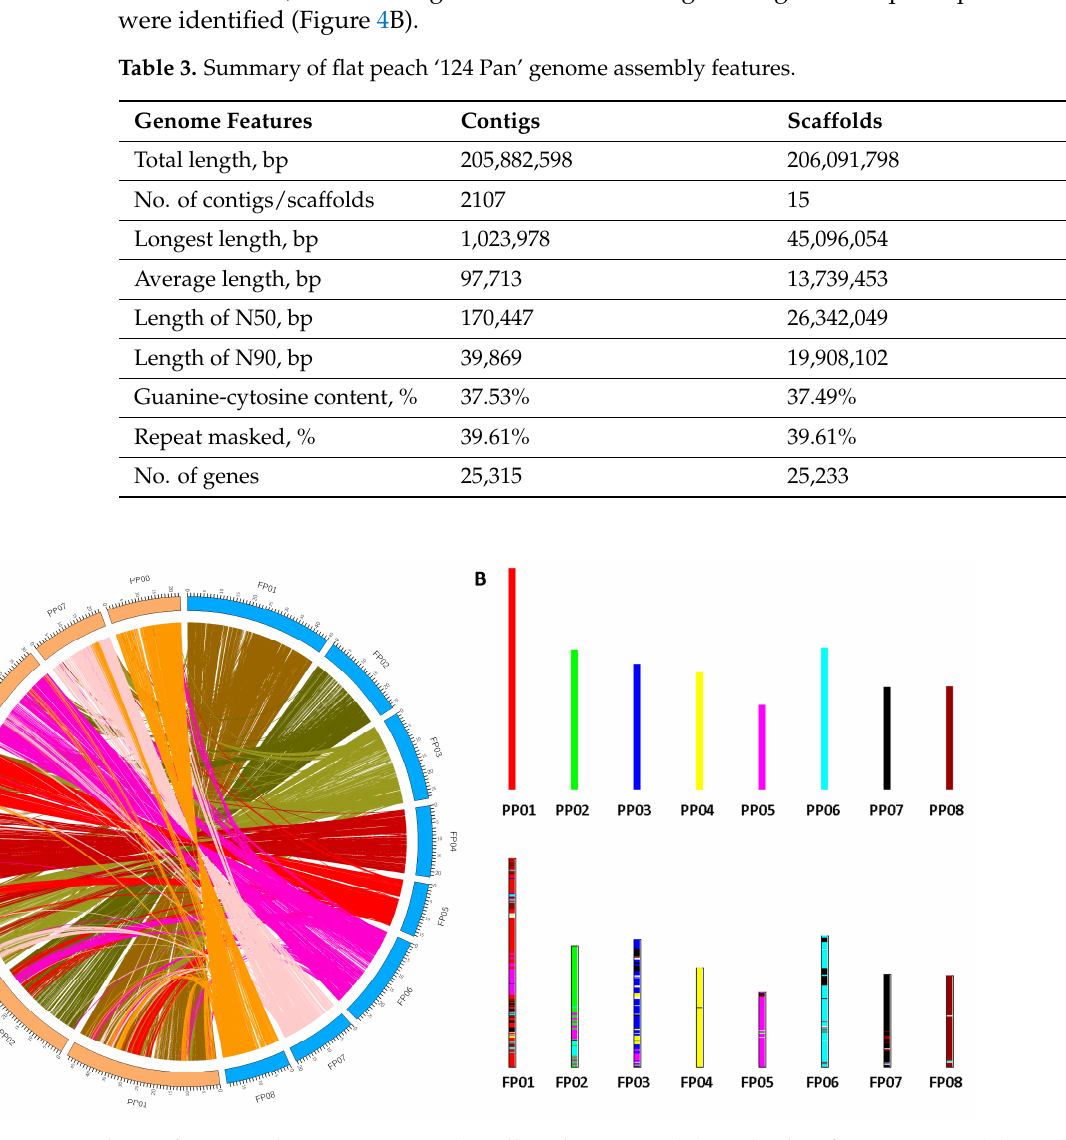
Figure 2. Comparative analyses of genomes between P. persica (Lovell) and ‘124 Pan’. ( A ) Circle plot of gene synteny. ( B ) Bar plot of chromosome fusions between P. persica (Lovell) and ‘124 Pan’. Different chromosomes are represented by different rainbow